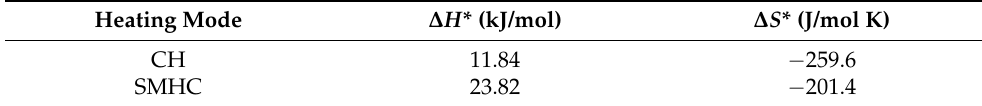
Figure 6. Dependence of ln ( k M / T ) on (1/ T ) for the case of SMHC and CH. The dependences of ln ( k M T ) on 1/ T , for both CH and SMHC, are straight lines, in the entire temperature range. The values ∆ H * and ∆ S * were calculated from the slope and the intercept of the above linear dependences. The calculated values of ∆ H * and ∆ S * are shown in Table 3. Table 3. Effects of heating mode on the values of ∆ H * and ∆ S